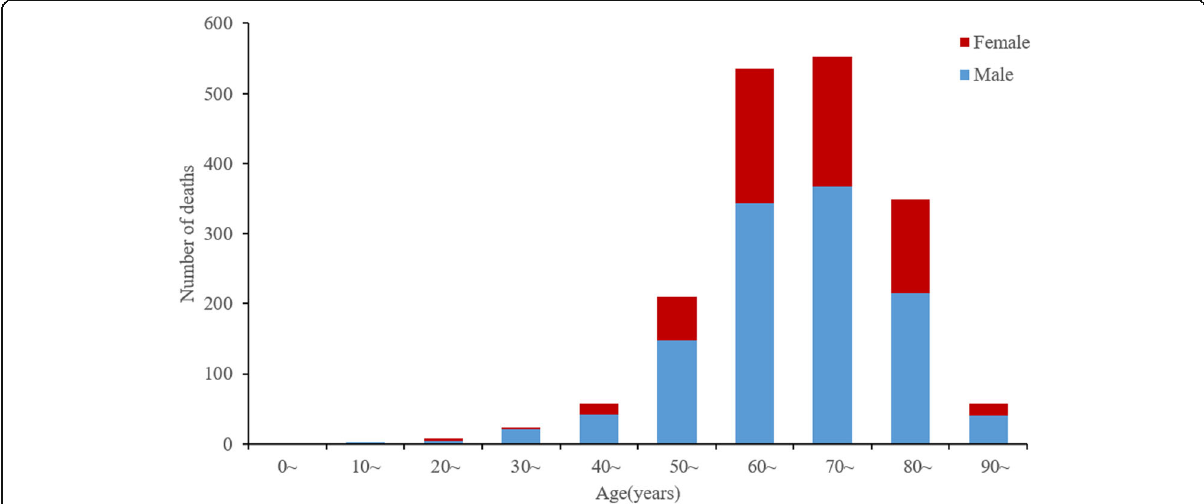
Fig. 1 The age distribution of deaths in